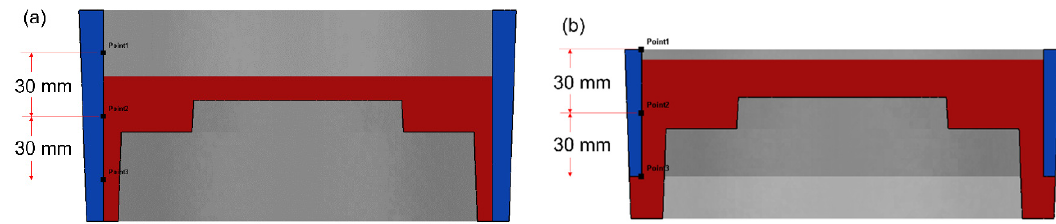
Figure 5. Surface temperature observation position of long ring ( a ) and short ring ( b ).